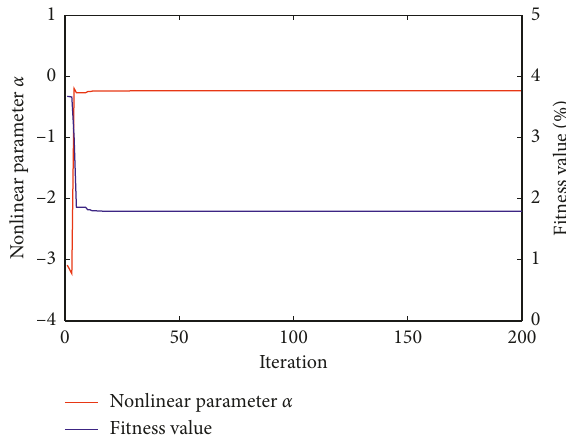
Figure 4: Convergence curve of WOA in Example